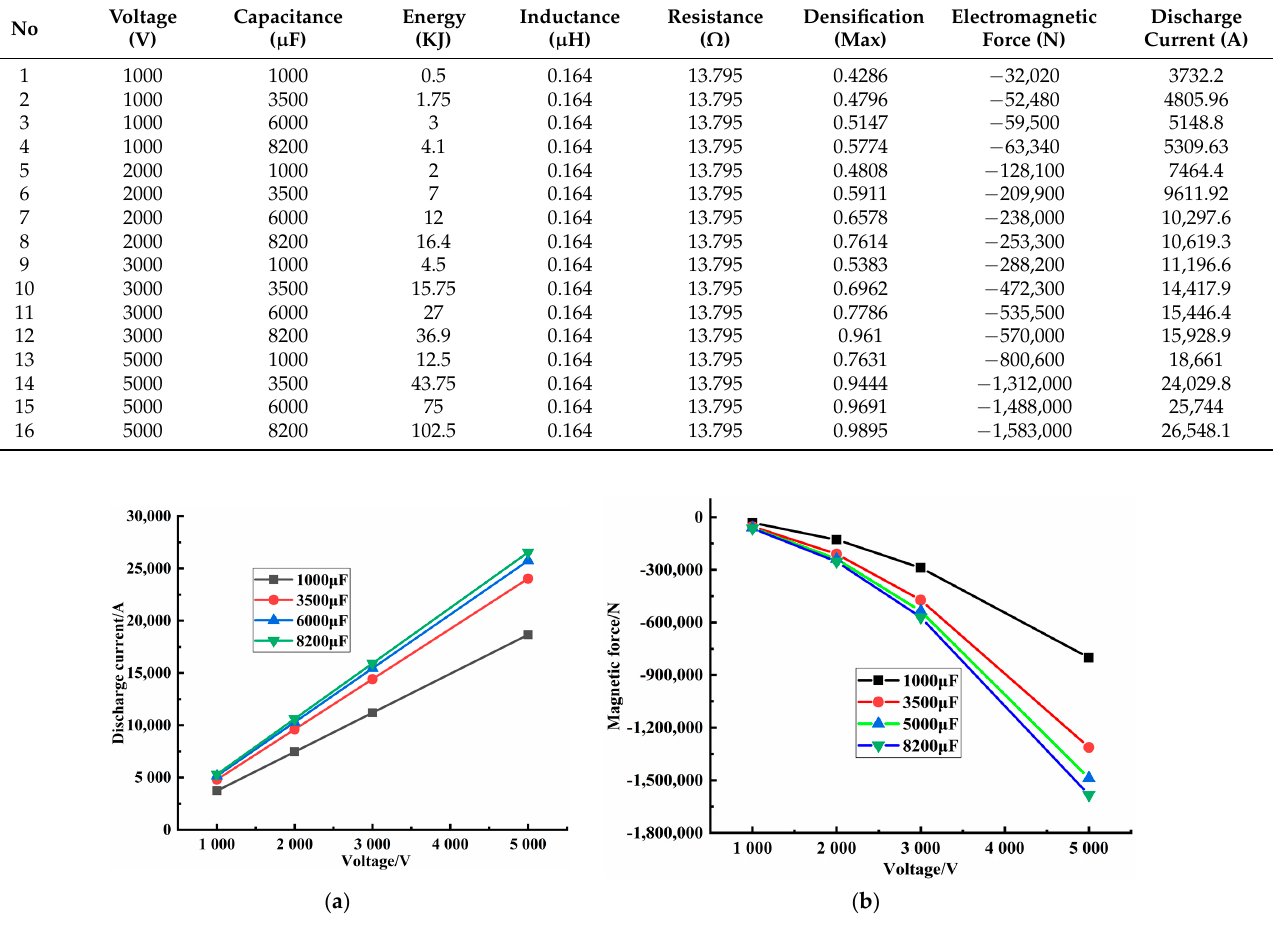
Table 4. Experimental plan and results.